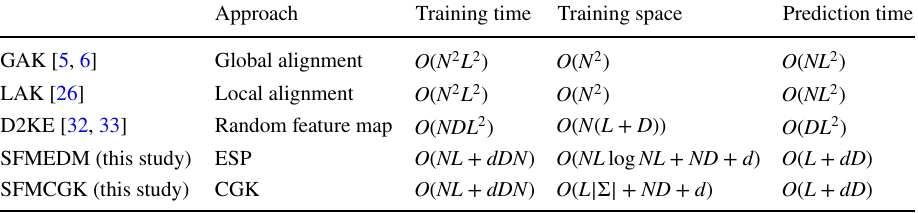
Table 1 Summary of string alignment